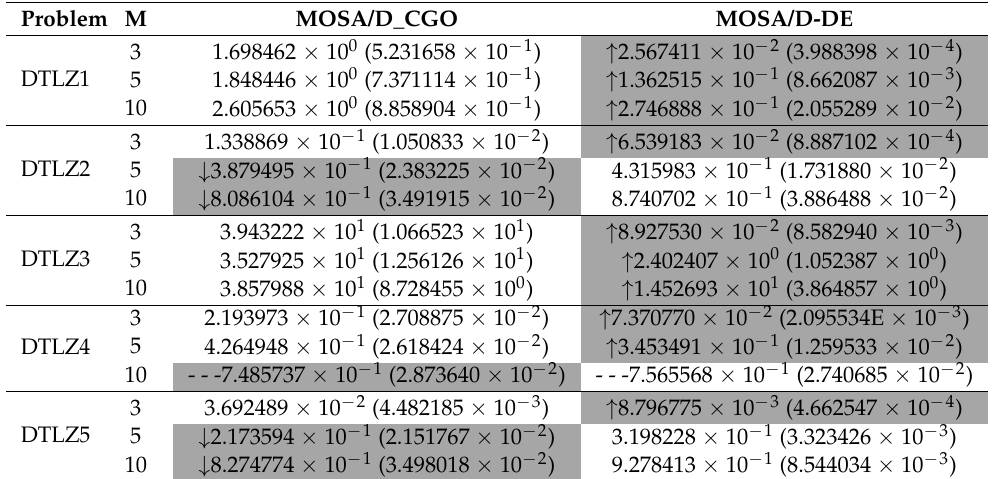
Table 8. Means and standard deviation of IGD results of 42